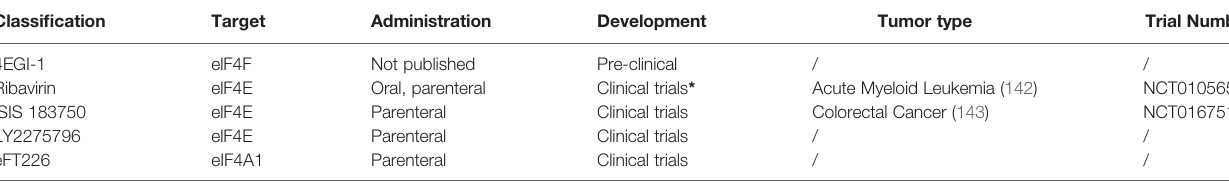
TABLE 2 | The inhibitors of eIFs in tumor and the speci fi c tumor types that can be inhibited in clinical trials. Classi fi